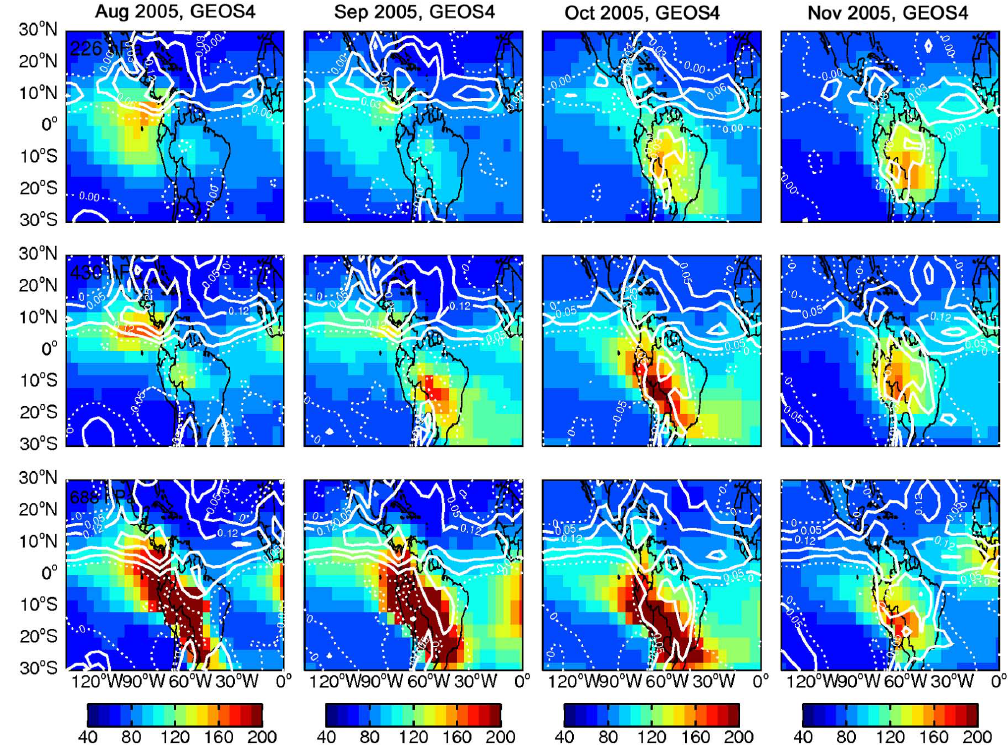
Fig. 9. Spatial patterns of the vertical air mass flux (contours in Pas − 1 ) superimposed on the CO mixing ratio (colors, in ppb) from August to December 2005 at 688 (bottom), 430, and 226 (top)hPa in the model driven by GEOS-4. The contour levels are: ( − 0.05, 0, 0.05, 0.12, 0.2) for 688 and 430hPa and ( − 0.05, 0, 0.03, 0.06, 0.12) for 226hPa. Positive values are upward fluxes (solid lines), negative values are downward fluxes (dashed